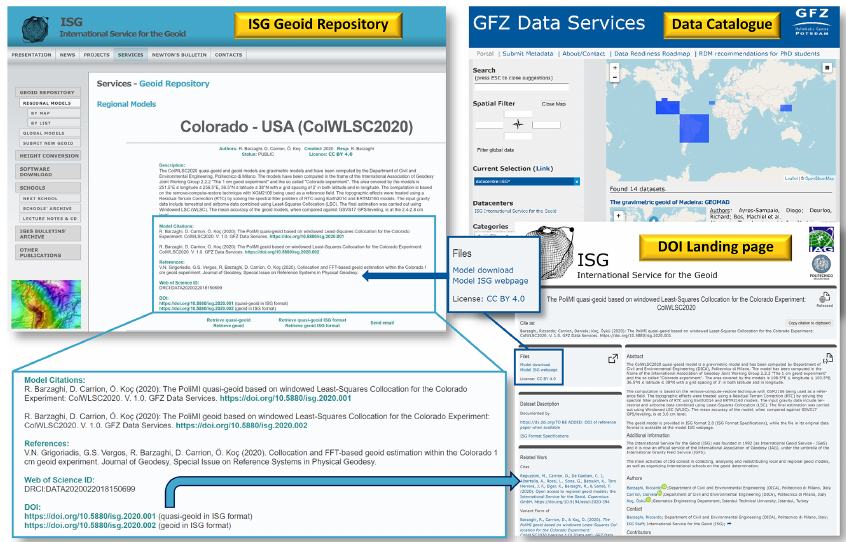
Figure 3. Overview on the relation between the ISG and GFZ Data Services for DOI-referenced geoid models of the Colorado experiment (ColWLSC2020). This project includes a quasi-geoid model (Barzaghi et al., 2020a) and a geoid model (Barzaghi et al., 2020b). Both models can be accessed via the dedicated web page in the ISG geoid repository (on the left) and via the DOI landing pages in GFZ Data Services (on the right). The “File” section of the DOI landing page includes the links to the model file and the corresponding web page in the ISG repository. On the other side, the ISG model web page is enhanced with the recommended citations of the DOI-assigned models and the links to the DOI landing pages at GFZ Data Services. The arrows show the cross-references between the two web